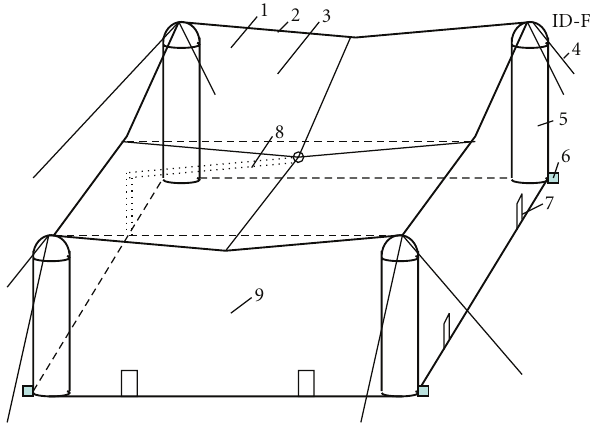
Figure 3: Column film dome. Notations: (1) film dome; (2) strong cable; (3) film; (4) bracing; (5) support inflatable column; (6) pumping station; (7) door; (8) pipe for rainwater; (9) film side wall.